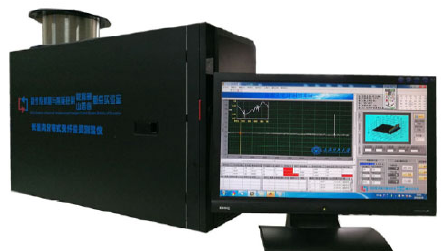
Fig. 3 Prototype of